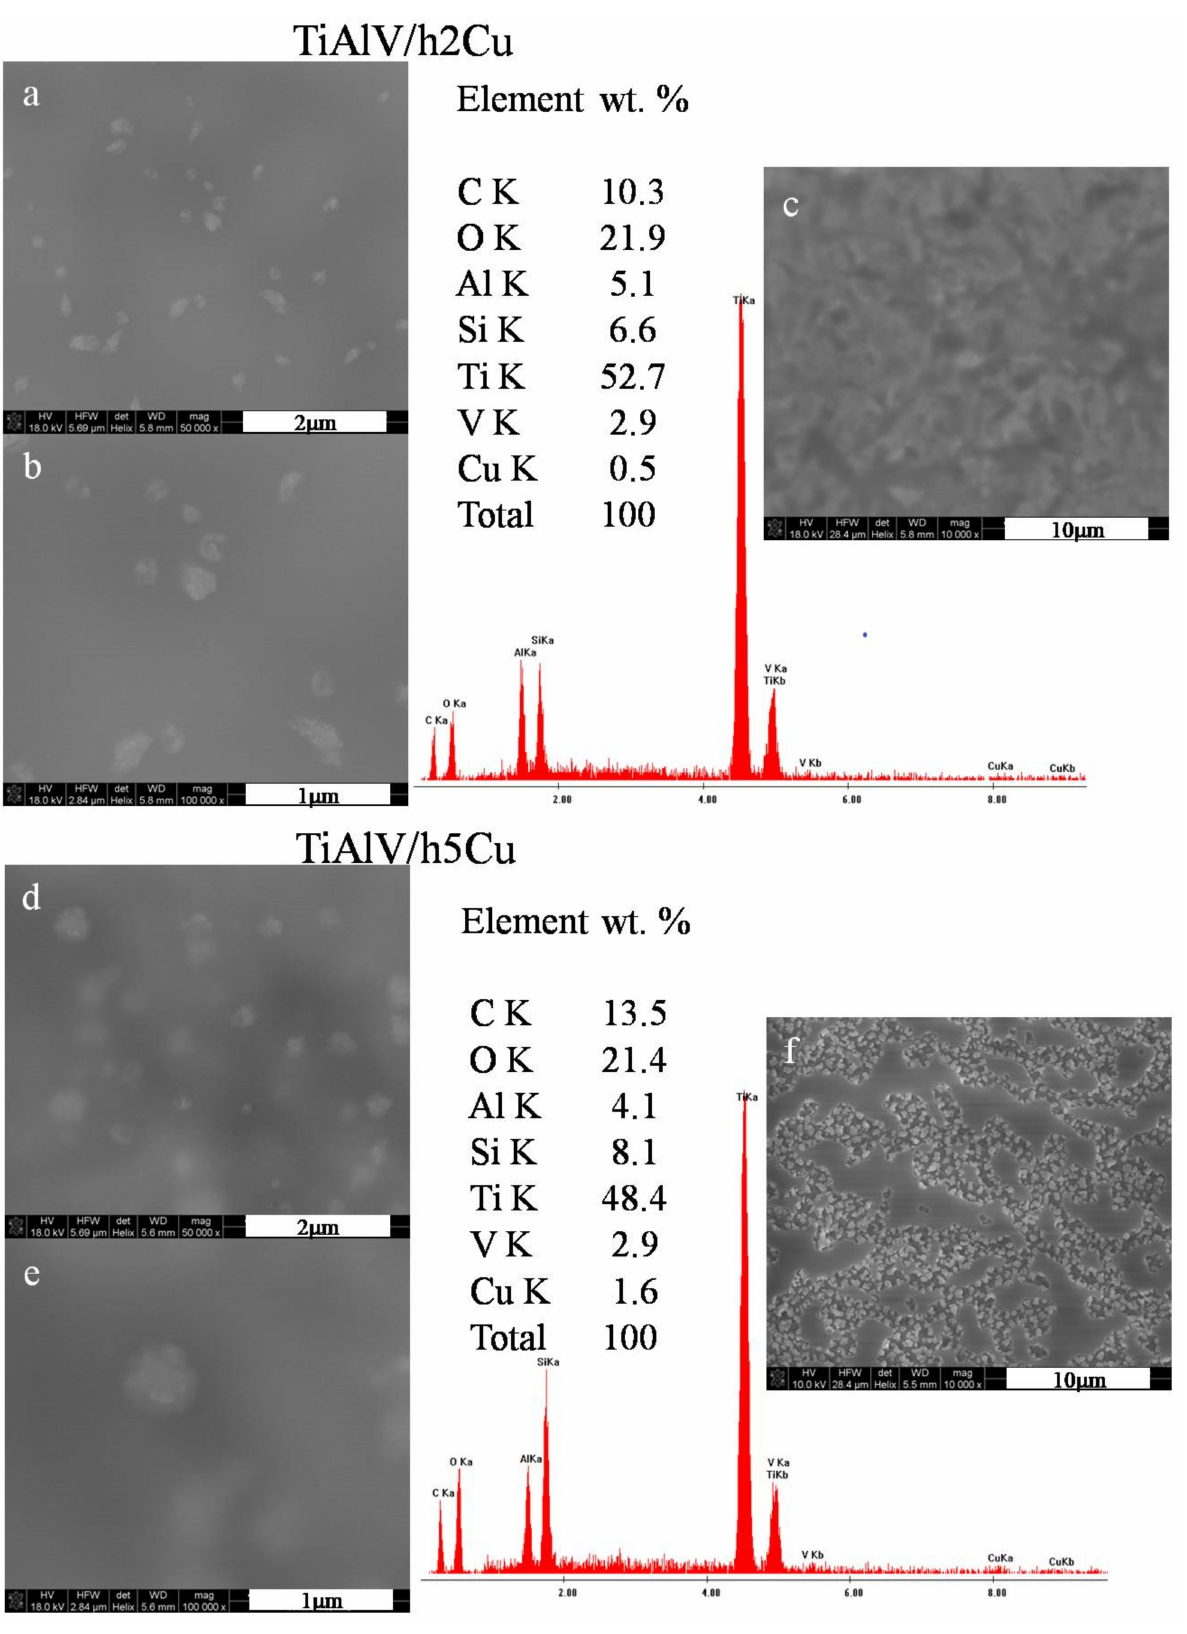
Figure 2. SEM images and EDS spectra of titanium alloy (TiAlV)-covered sol–gel hybrid layer containing copper nanoparticles; ( a – c ) containing 2% CuNPs, and ( d – f ) containing 5%